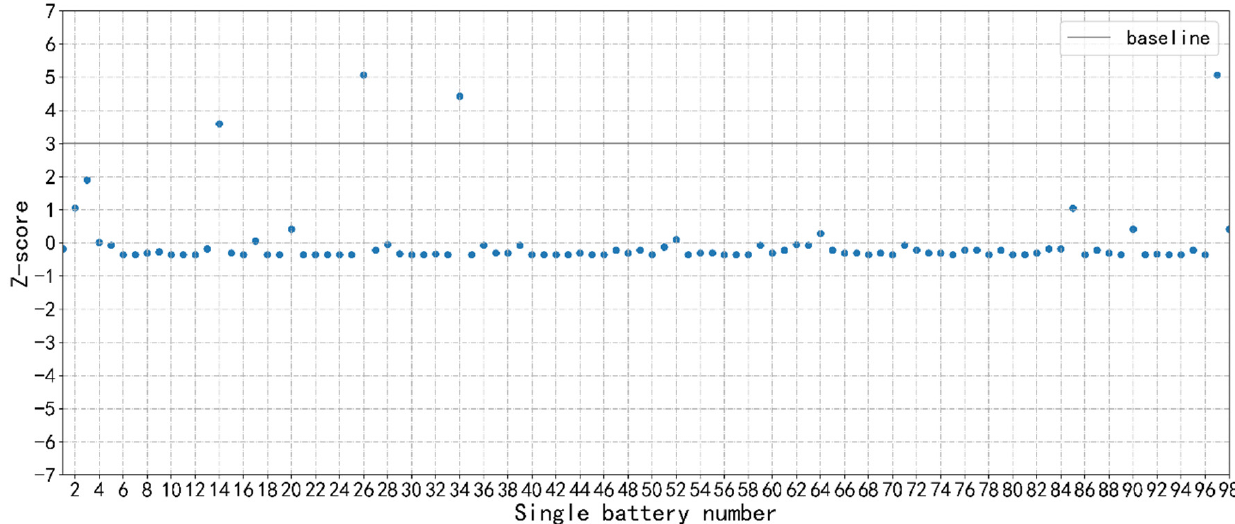
Figure 15. Z-scores of differential area of cell voltages.